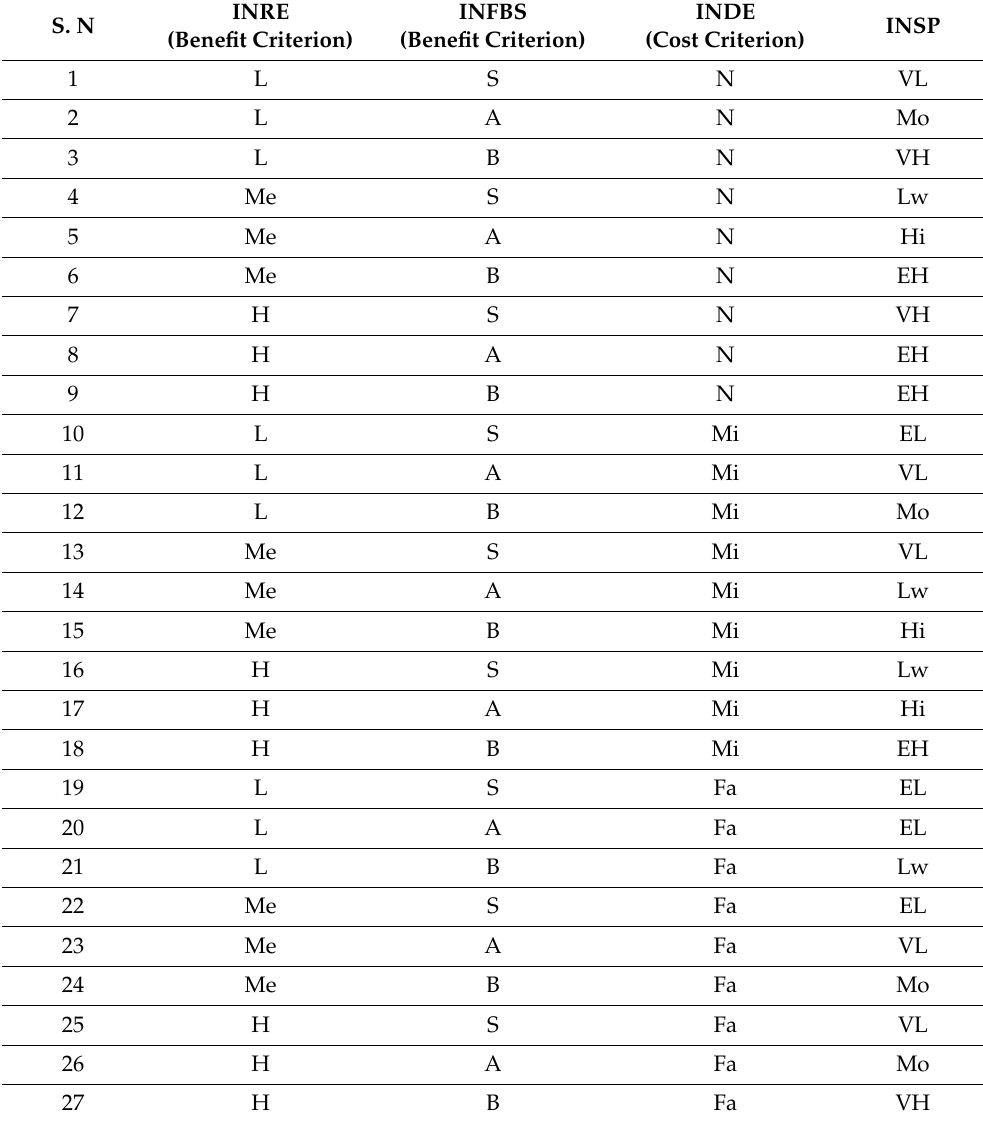
Table 6. Decision matrix.